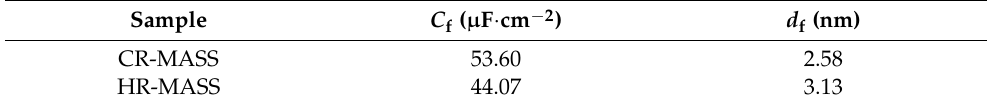
Table 4. The calculated values of the effective capacitance ( C f ) and passive film thickness ( d f ) of the experimental MASS based on EIS